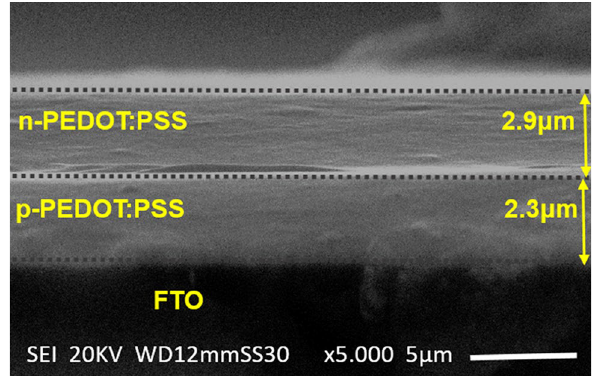
Figure 4. SEM cross-sectional image of the fabricated PEDOT:PSS homojunction p–n diode (p-PEDOT:PSS/ n-PEDOT:PSS).